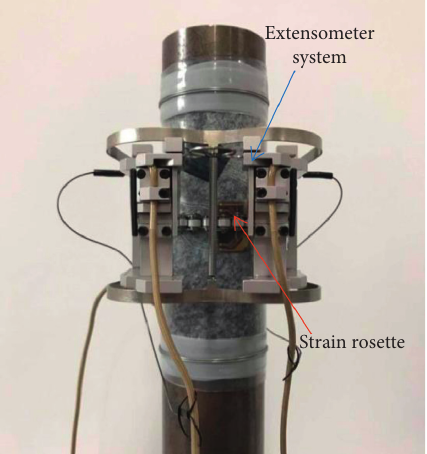
Figure 9: Extensometer and the strain monitoring system during the